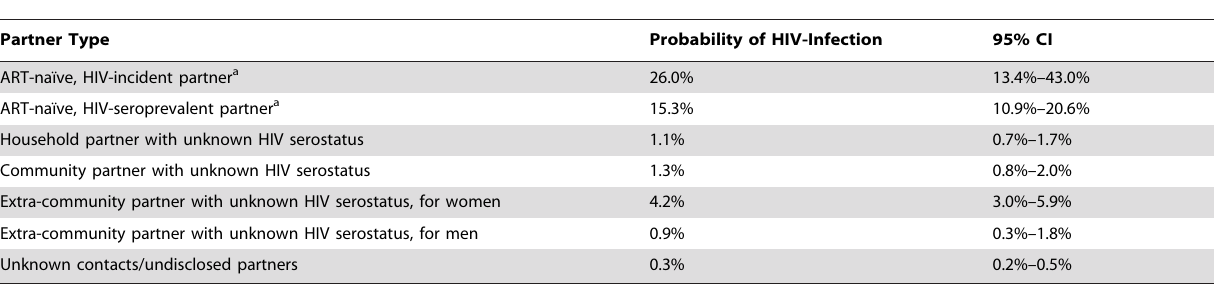
Table 5. Probability of HIV infection by partner type over 18-mo study interval.